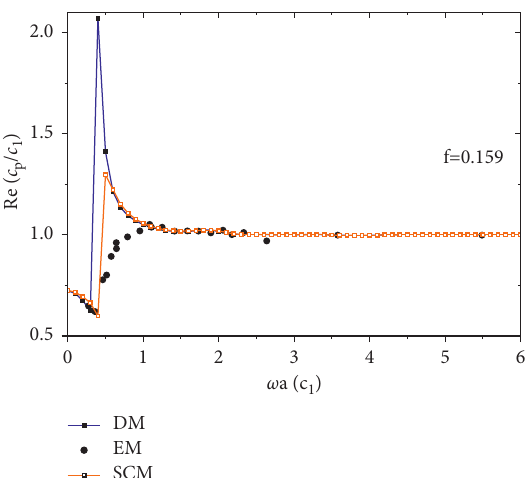
Figure 3: Comparison of ratios of the phase velocity in the composite material and matrix obtained by the differential method (DM) and self-consistent method (SCM), and experimental results (ER) in the case of quasi-P wave propagates in the composite material for inclusion volume fraction of 15.9% and δ �